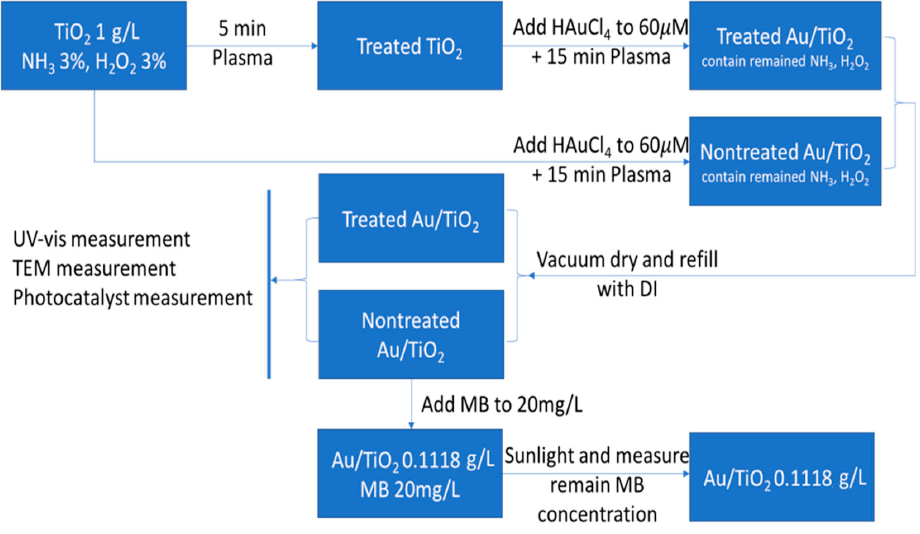
Figure 2. Schematic synthesis and diagnostic procedures of Au/TiO 2 composites.